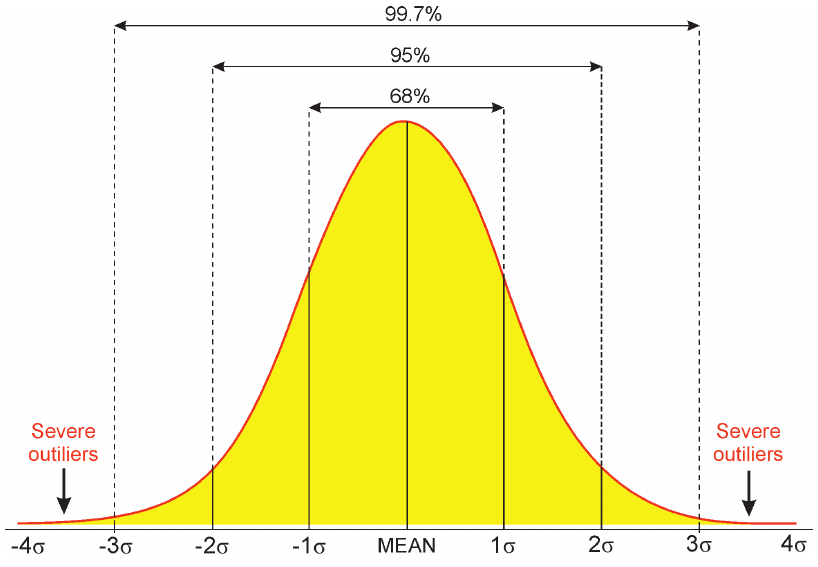
Figure 3. Normal distribution curve. Table 4. Raw